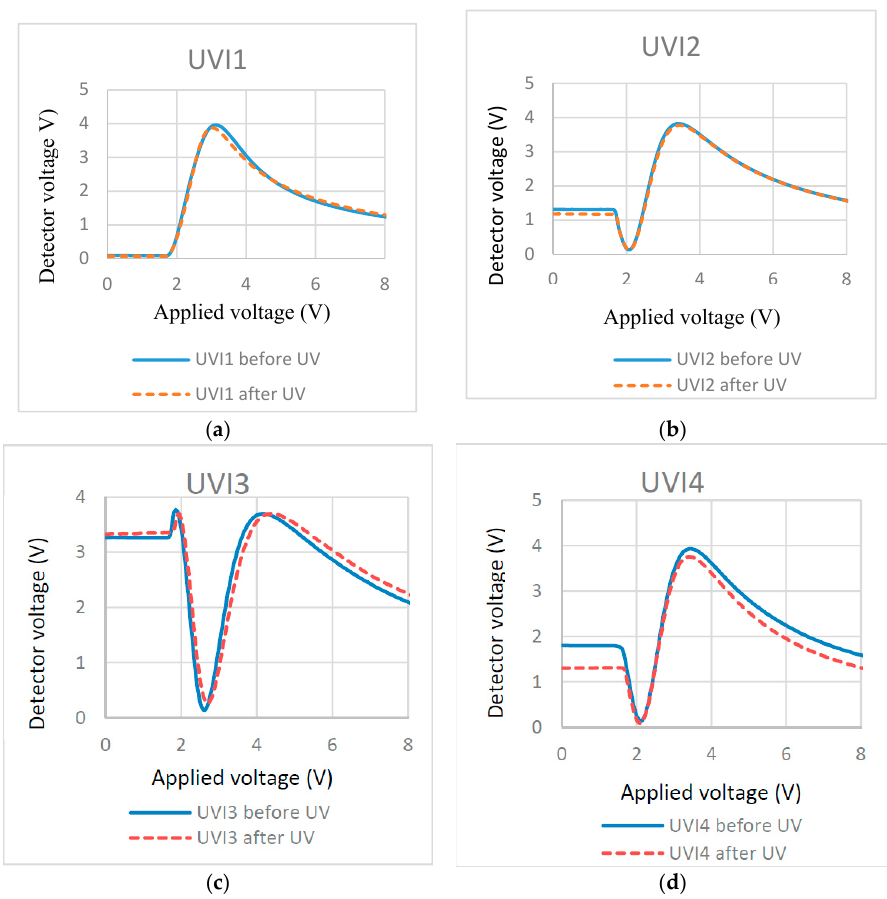
Figure 8. T/V curves of cells cured at different UV exposure intensity and time: ( a ) 0.75 mW/cm 2 for 70 min; ( b ) 3.5 mW/cm 2 for 10 min; ( c ) 21 mW/cm 2 for 2.5 min; and ( d ) 21 mW/cm 2 for 10 min.